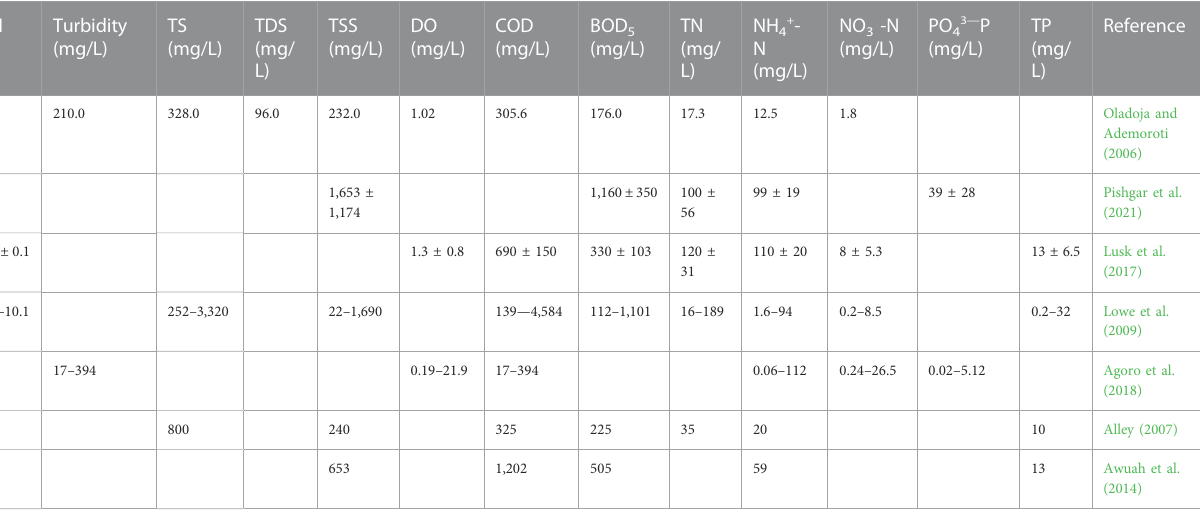
TABLE 1 Physicochemical properties of domestic